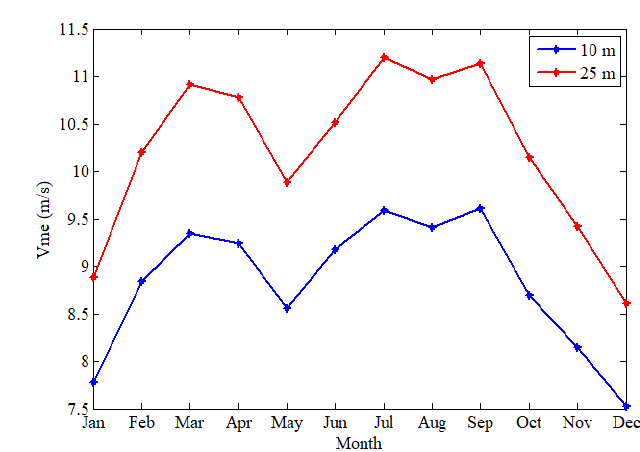
Figure 4. Variation of the wind speed giving the maximum energy as a function of the altitude